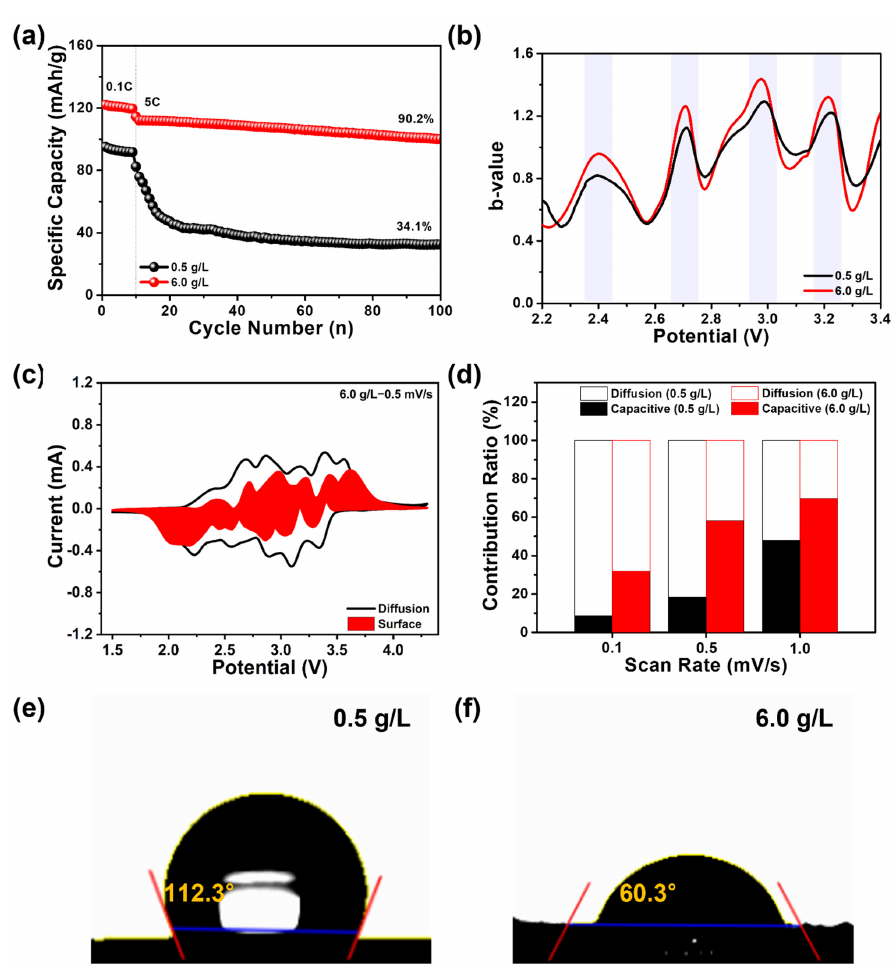
Figure 4. ( a ) high ‐ rate cycling capability; ( b ) continuous b ‐ value measured in potential range from 2.2 to 3.4 V along the cathodic scan; ( c ) CV curves of the 6.0 g/L electrode at 0.5 mV/s; each charac ‐